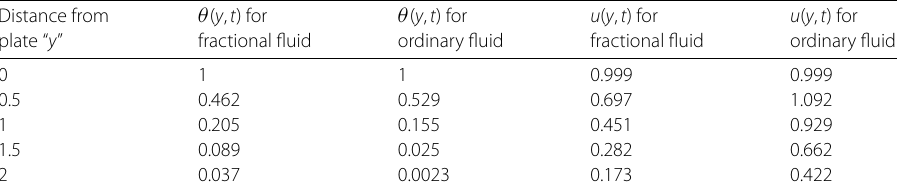
Table 1 Numerical values of θ ( y , t ) and u ( y , t ) for fractional and ordinary fluid models θ ( y , t ) for θ ( y , t ) for Distance from u ( y , t ) for u ( y , t ) for plate “ y ” fractional fluid ordinary fluid fractional fluid ordinary fluid 0 1 1 0.999 0.999 0.5 0.462 0.529 0.697